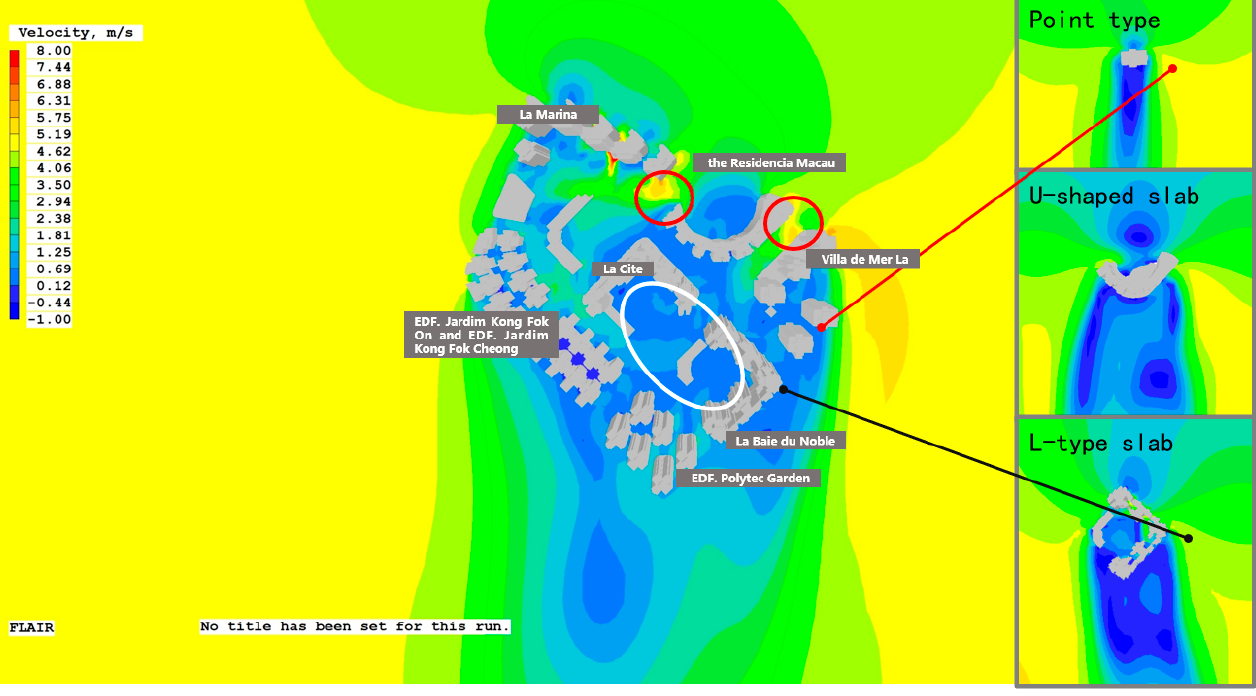
Figure 9. Wind speed performance of building complexes in Areia Preta.